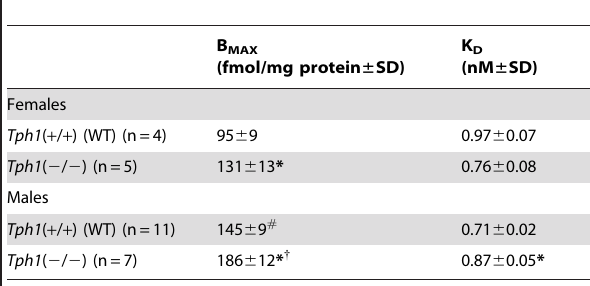
Table 1. SERT Binding Parameters in Mouse Lung.